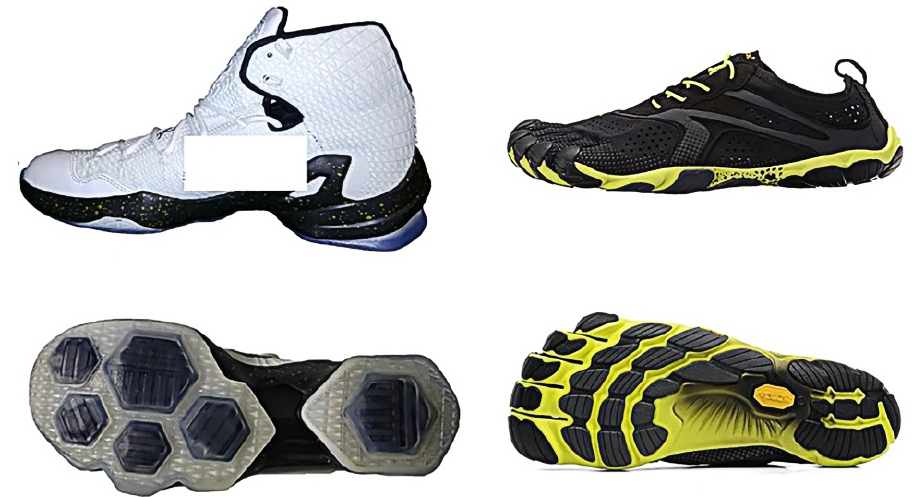
Figure 1. Highly-cushioned shoes, HS ( left ) and less cushioned shoes, CS ( right ).